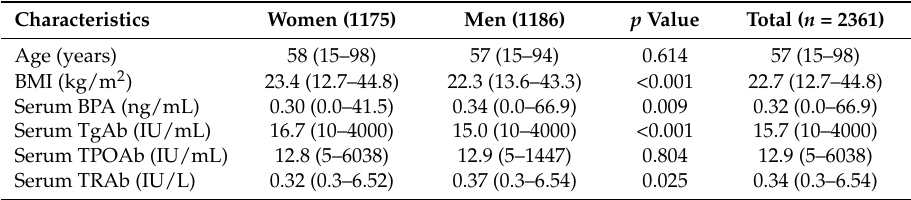
Table 1. Baseline characteristics of the study population.